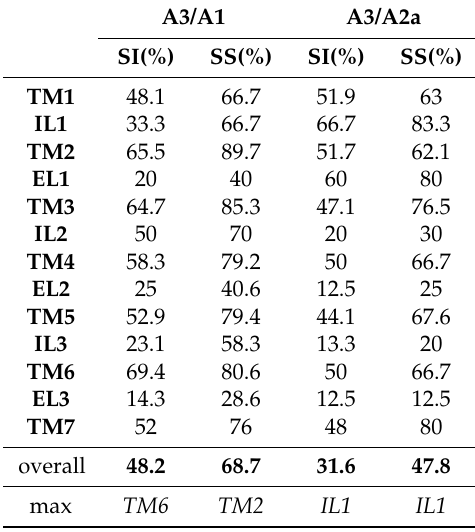
Table 2. Sequence identity (SI) and sequence similarity (SS) percentages calculated for each alignment performed on structural domains of crystal structures 5UEN (hA 1 AR) and 3PWH (hA 2A ). Overall values are also reported along with domains showing the highest SI and SS